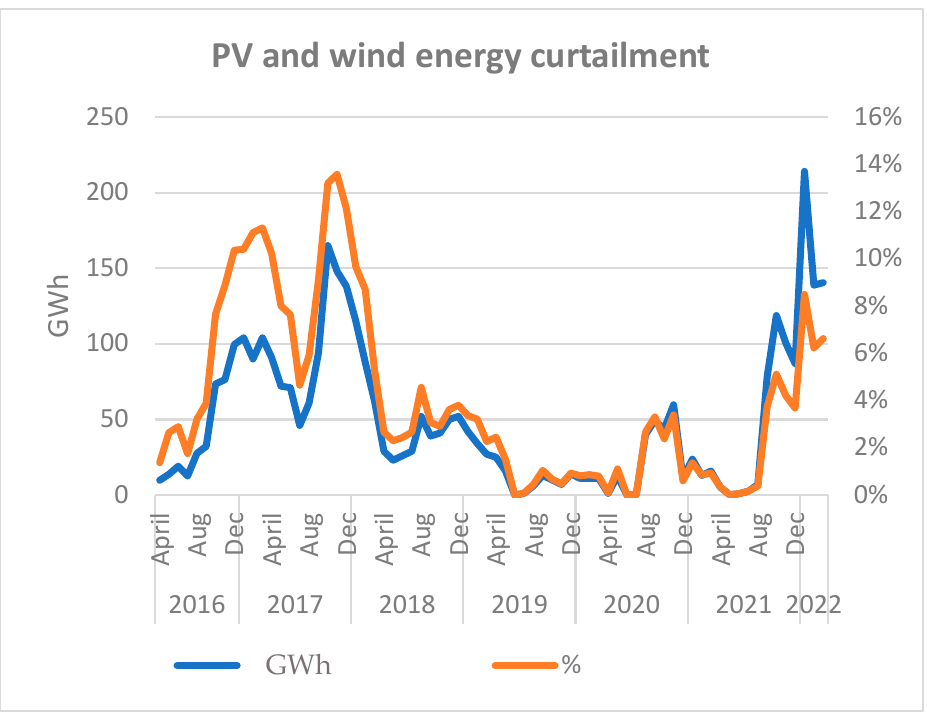
Figure 2. PV and wind energy curtailment. Source: Own elaboration based on data from the Coordinator, https://www.coordinador.cl/wp-content/uploads/2022/04/Informe-diario-20-04-2022.pdf (accessed on 5 April 2022).